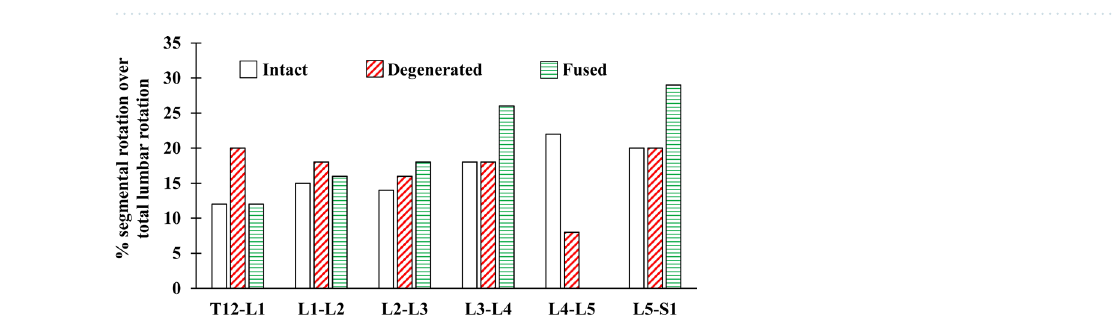
Figure 3. Flowchart of the conditions considered to simulate preoperative (intact and degenerated) as well as fused models.